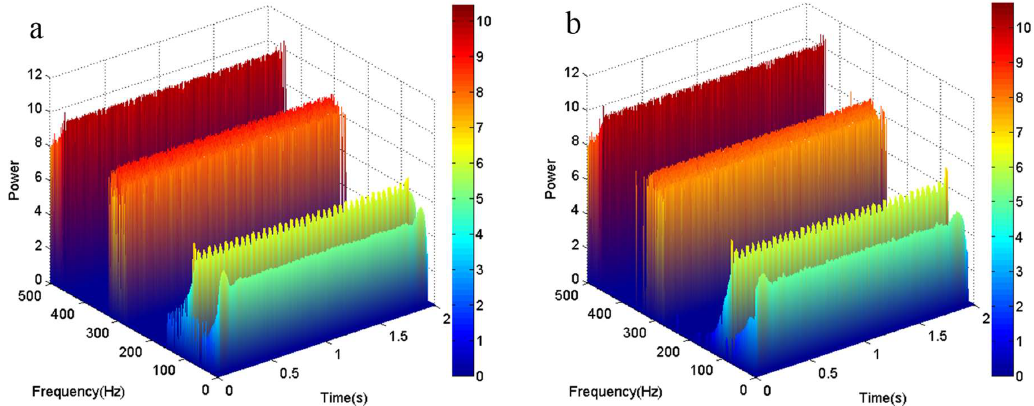
Figure 6. The three-dimensional time-frequency-power spectrum of the signal y 3 ( t ). ( a ) The three-dimensional time-frequency-power spectrum obtained by the original EMD method; ( b ) The three-dimensional time-frequency-power spectrum obtained by the local linear extrapolation method.